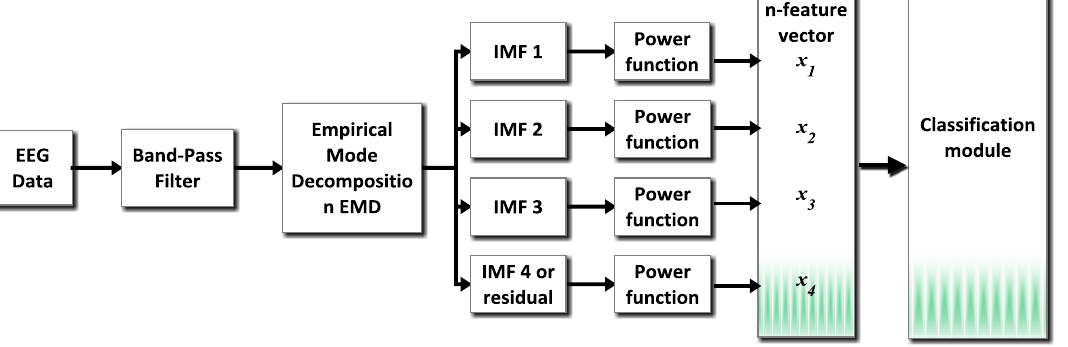
Figure 13. General scheme of detection system proposed.